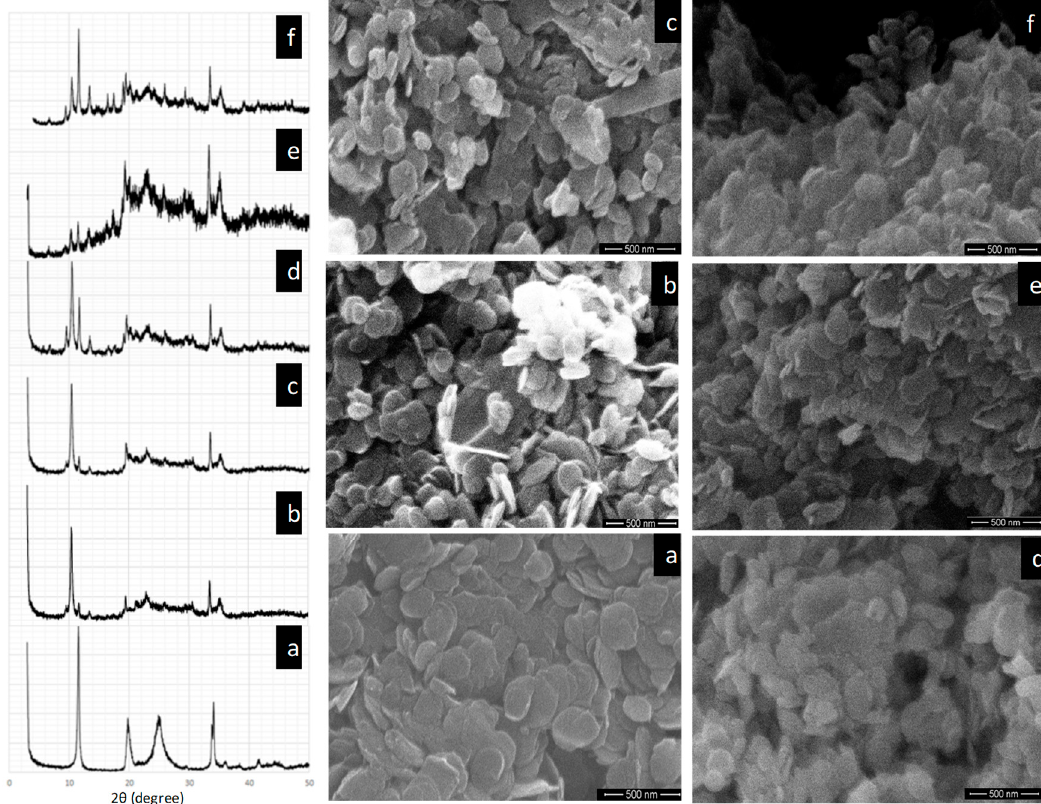
Figure 1. ( a ) X-ray diffractometer (XRD) pattern and scanning electron microscope (SEM) image of ZrP. ( b ) XRD pattern and SEM image of metal-organic framework (MOF)-ZrP with two layers. ( c ) XRD pattern and SEM image of MOF-ZrP with four layers. ( d ) XRD pattern and SEM image of MOF-ZrP with six layers. ( e ) XRD pattern and SEM image of MOF-ZrP with eight layers. ( f ) XRD pattern and SEM image of MOF-ZrP with 10 layers.